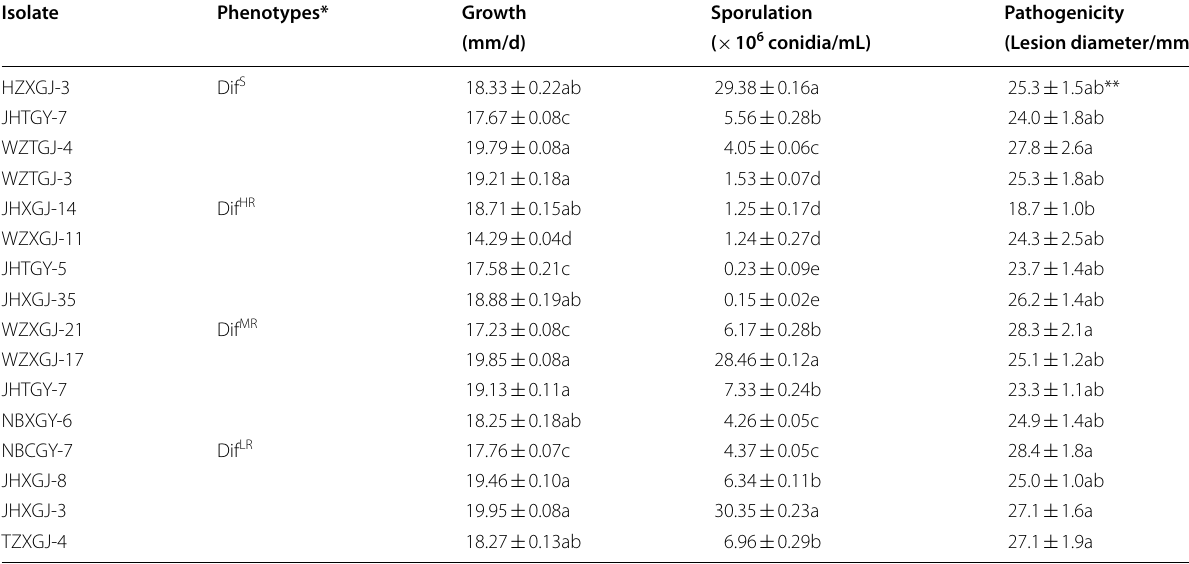
Table 2 Biological characteristics of difenoconazole-sensitive and -resistant